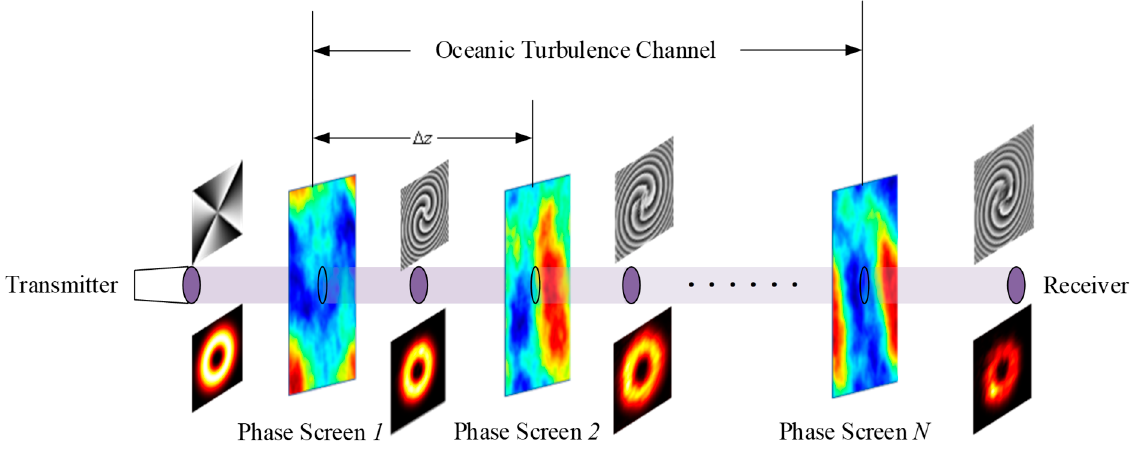
Figure 1. Ocean turbulence stochastic phase screen model.